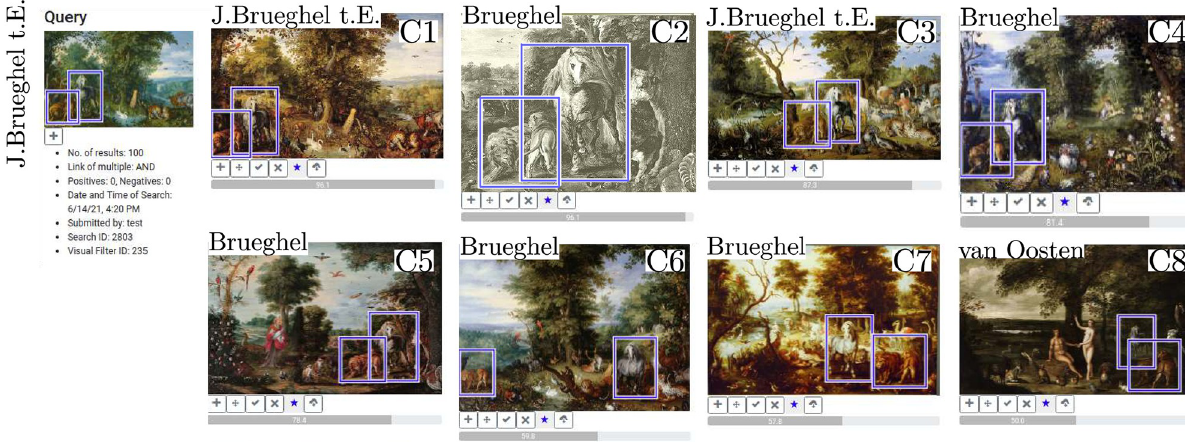
Fig 8. Search results for the horse and the group of lions. The selected query regions are displayed on the left, retrievals marked as particularly interesting are displayed on the right. Favourite retrievals were selected from the first 40 results (first two retrieval pages). Additionally, we added the artist’s name for a better orientation. “Brueghel” was used as an umbrella term and includes members of the Brueghel family, their workshops and successors who painted in their style. For these works, the attribution is uncertain. Image material is shared by Wikimedia Commons [5] either as public domain or under a CC0